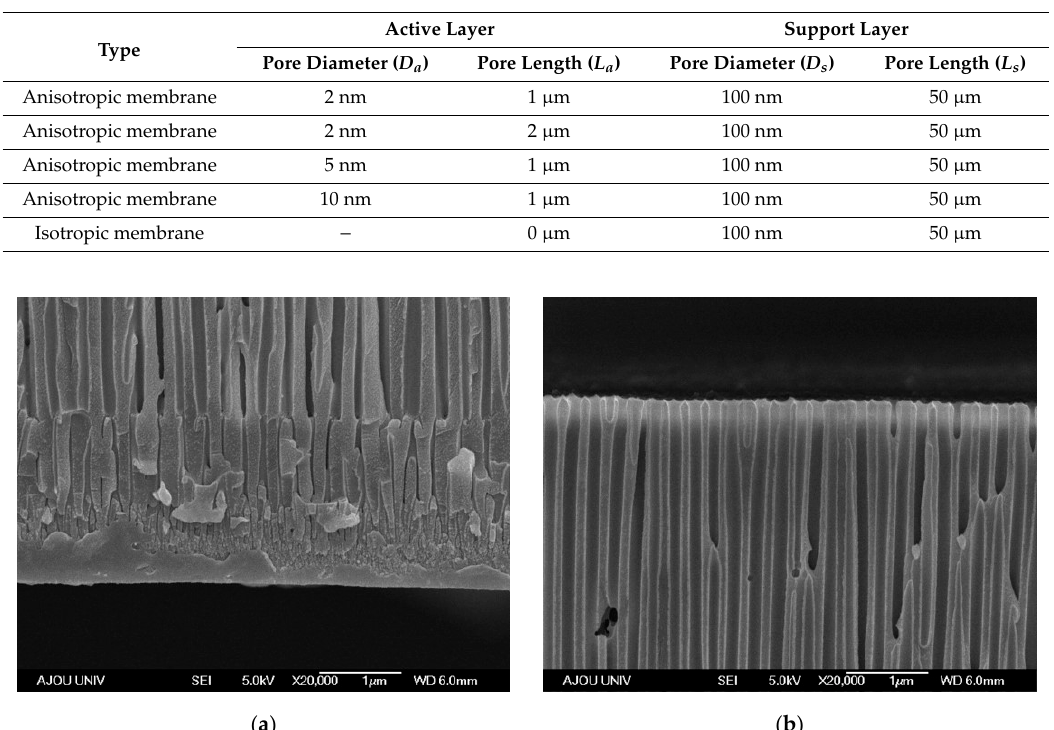
Table 1. Dimensions of the nanoporous aluminum oxide membranes used in the study.